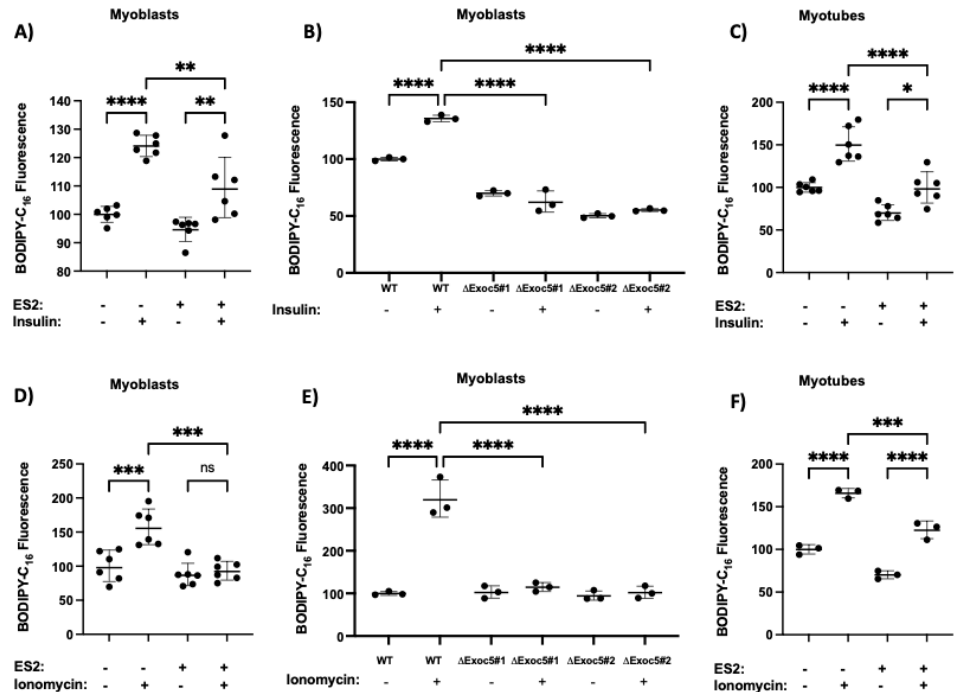
Figure 3. Disrupted exocyst function hinders FFA uptake in response to stimuli. Measurement of fluorescent long − chain FFA analog BODIPY − C16 uptake in wild − type ( A ) and ∆ EXOC5 skeletal myoblasts ( A , B ) and differentiated myotubes ( C ) in response to insulin reveals that impaired exocyst function hinders FFA uptake. Measurement of fluorescent long − chain FFA analog BODIPY − C16 uptake in wild − type ( D ) and Δ EXOC5 skeletal myoblasts ( E ) and differentiated myotubes ( F ) in response to ionomycin treatment demonstrates that defective exocyst activity impedes FFA uptake in this model. Data are means ±S.D. in percent ratios relative to the untreated or wild − type controls. * p < 0.05; ** p < 0.01; *** p < 0.005; **** p < 0.0005; ns: p > 0.05. Data presented are representative of three independent measurements.